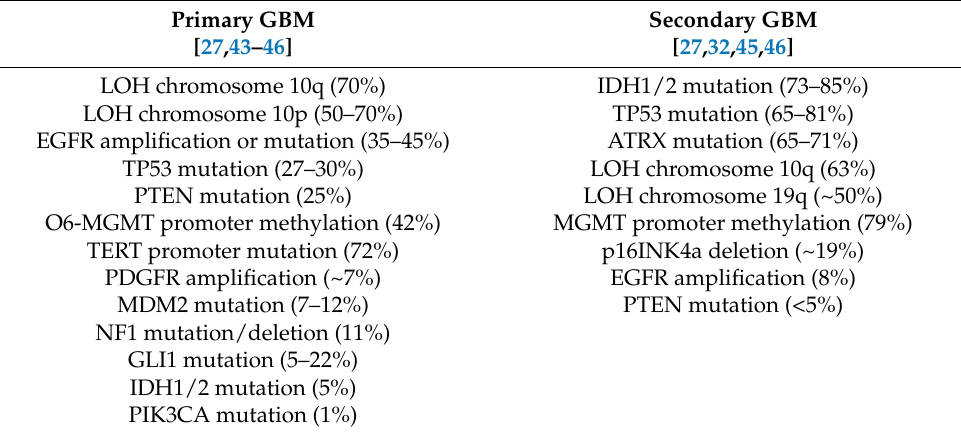
Table 1. Genetic alterations of primary and secondary Glioblastoma